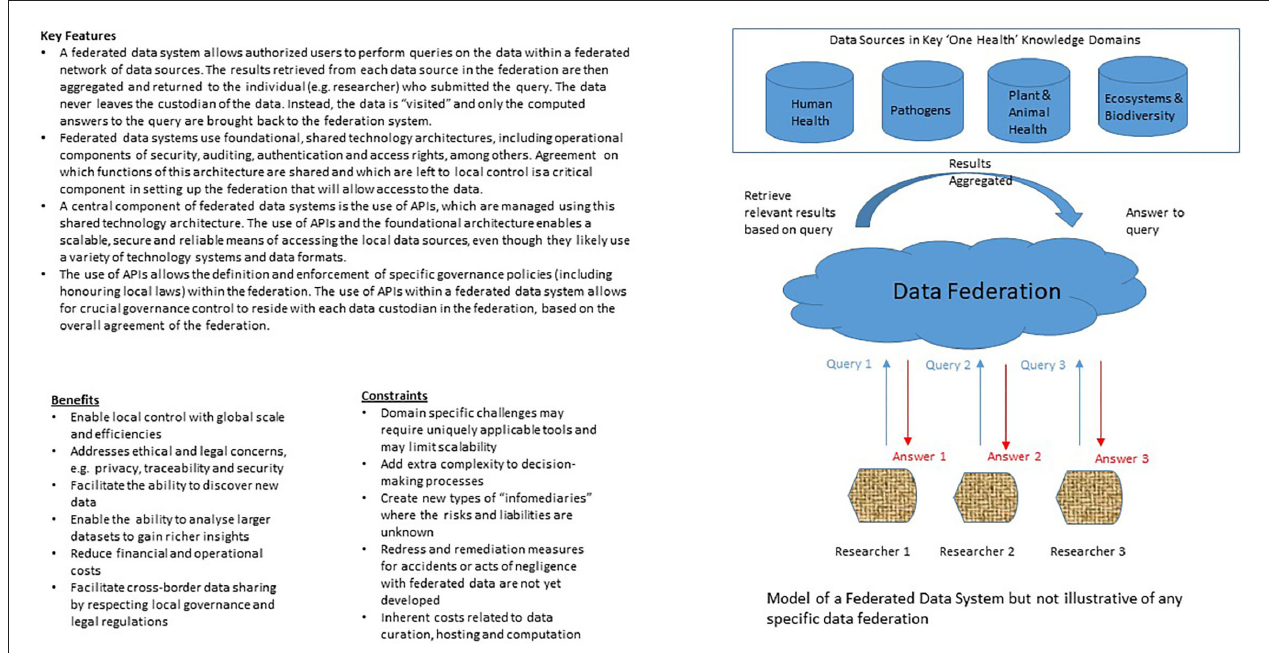
FIGURE 1 | Key elements of federated data systems (8, 79,